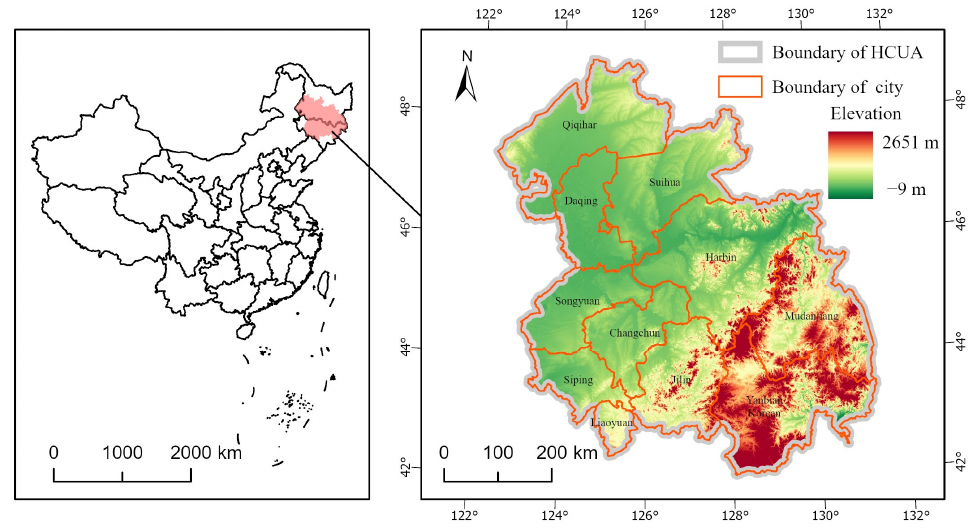
Figure 1. Location of the study area.